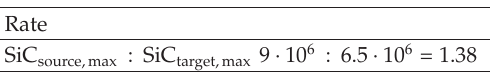
Table 7: Rate of